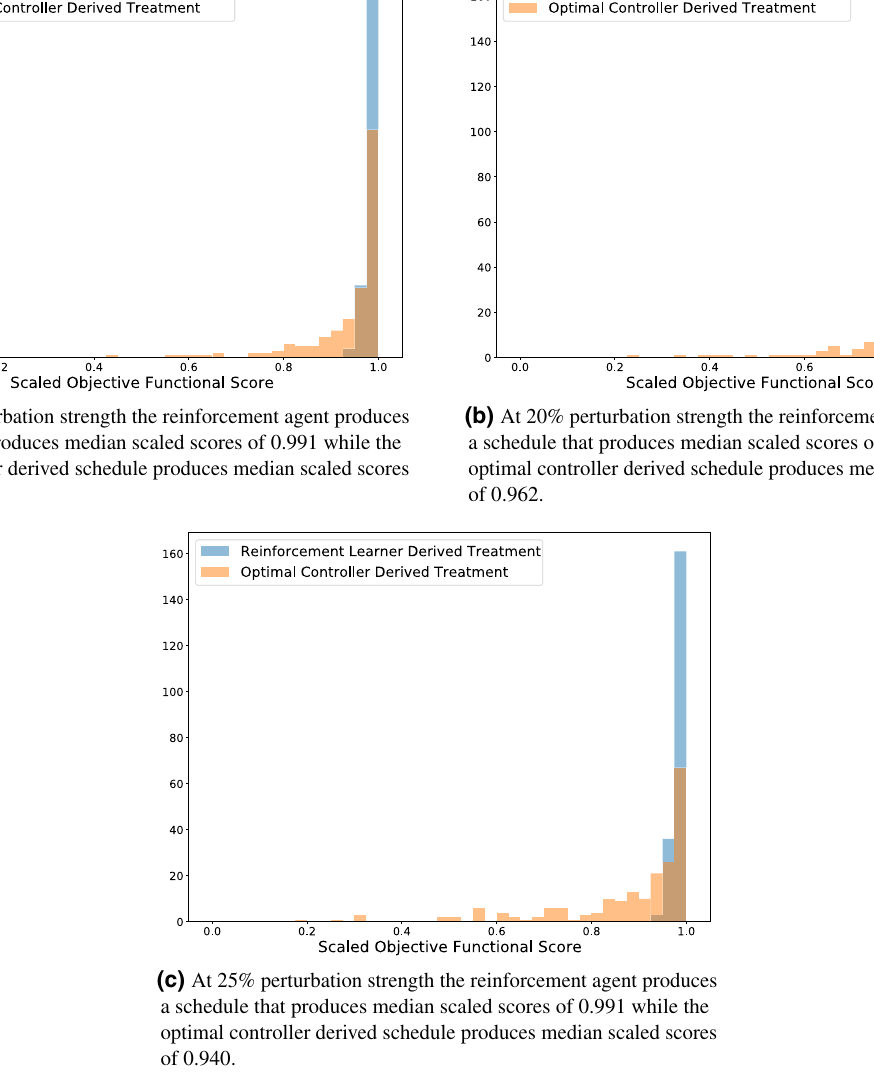
Figure 8. Histograms of the scores achieved by the various agents on the 200 testing virtual patients. Bin sizes were chosen to correspond to 0.025. In particular, the reinforcement learning agent is much more robust toward perturbation in parameter values, consistently producing dosing schedules scoring within 7.5% of the theoretical maximal